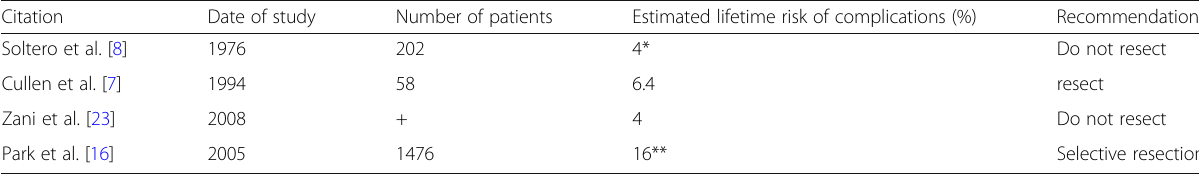
Table 2 Resection recommendations for incidental